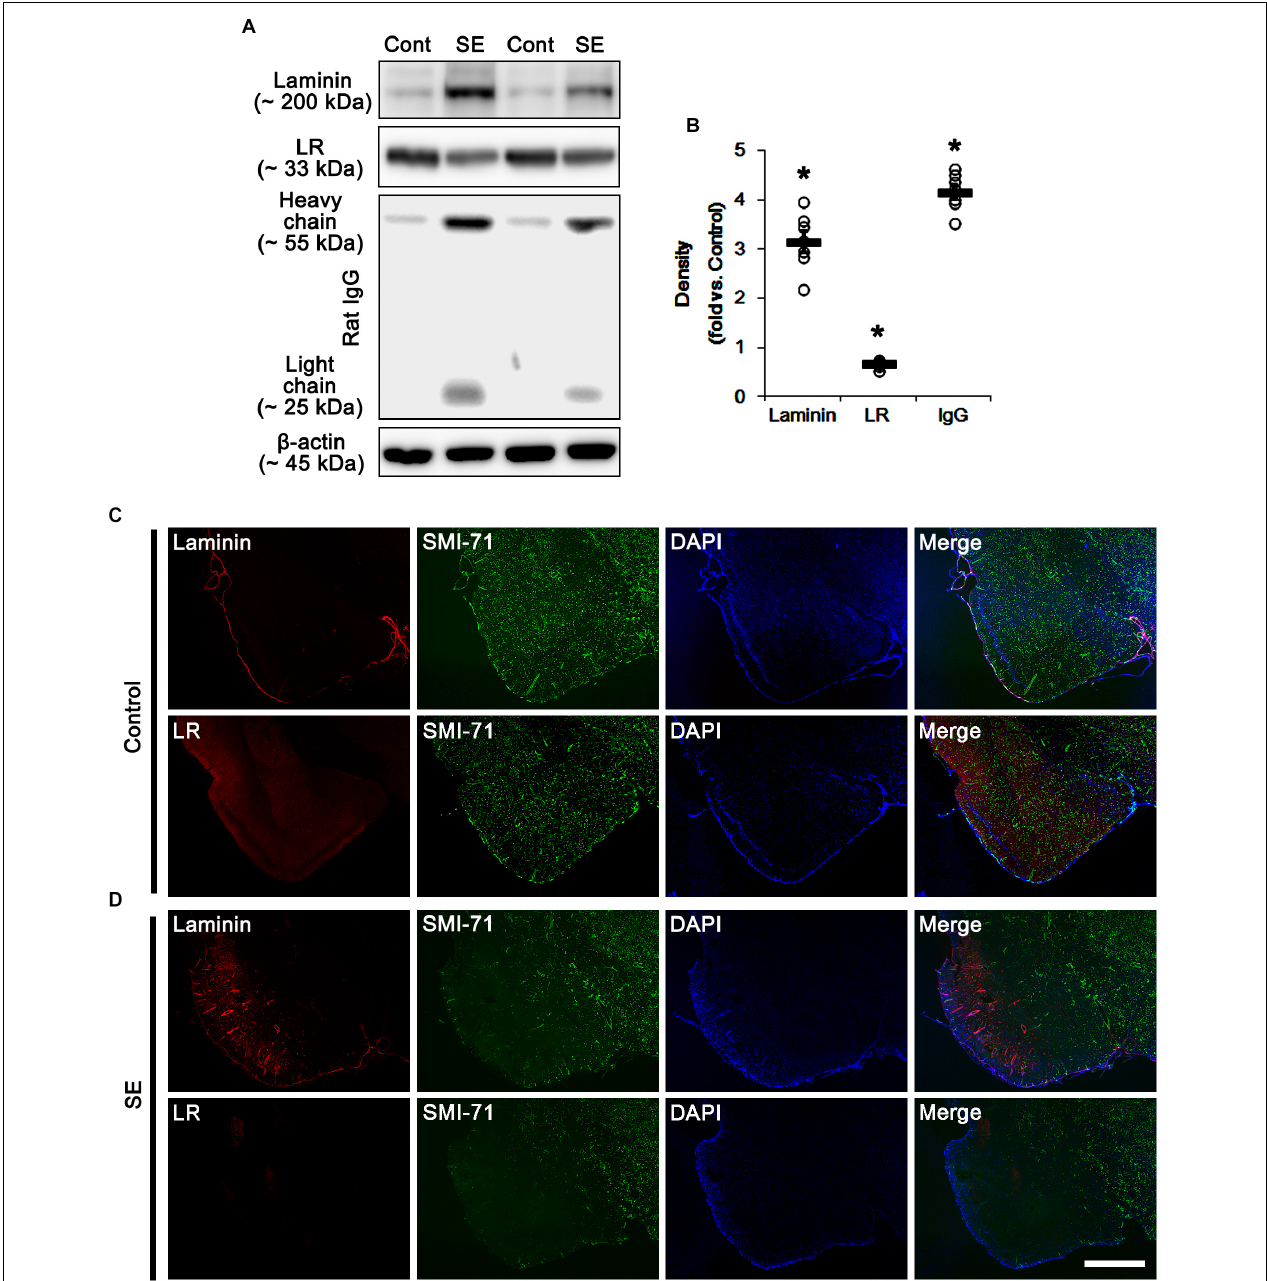
FIGURE 1 | Alterations in laminin and 67-kDa LR (LR) expression in the PC following SE. (A) Western blot image for expression levels of laminin and 67-kDa LR, and serum extravasation following SE. SE increases laminin expression and serum extravasation, but reduces 67-kDa LR expression. (B) Quantitative values (mean ± S.E.M) of the Western blot data concerning expression levels of laminin and 67-kDa LR, serum extravasation induced by SE ( n = 7, respectively). Open circles indicate each individual value. Horizontal bars indicate mean value. Significant differences are ∗ p < 0.05 vs. control animals (Student t -test). (C,D) Representative photographs of expression levels of laminin and 67-kDa LR in vasogenic edema (SMI-71-deleted) lesion in the PC in control (C) - and post-SE condition (D) . In SMI-71-deleted area, laminin expression is enhanced, while 67-kDa LR expression is decreased. Bar = 400 µ